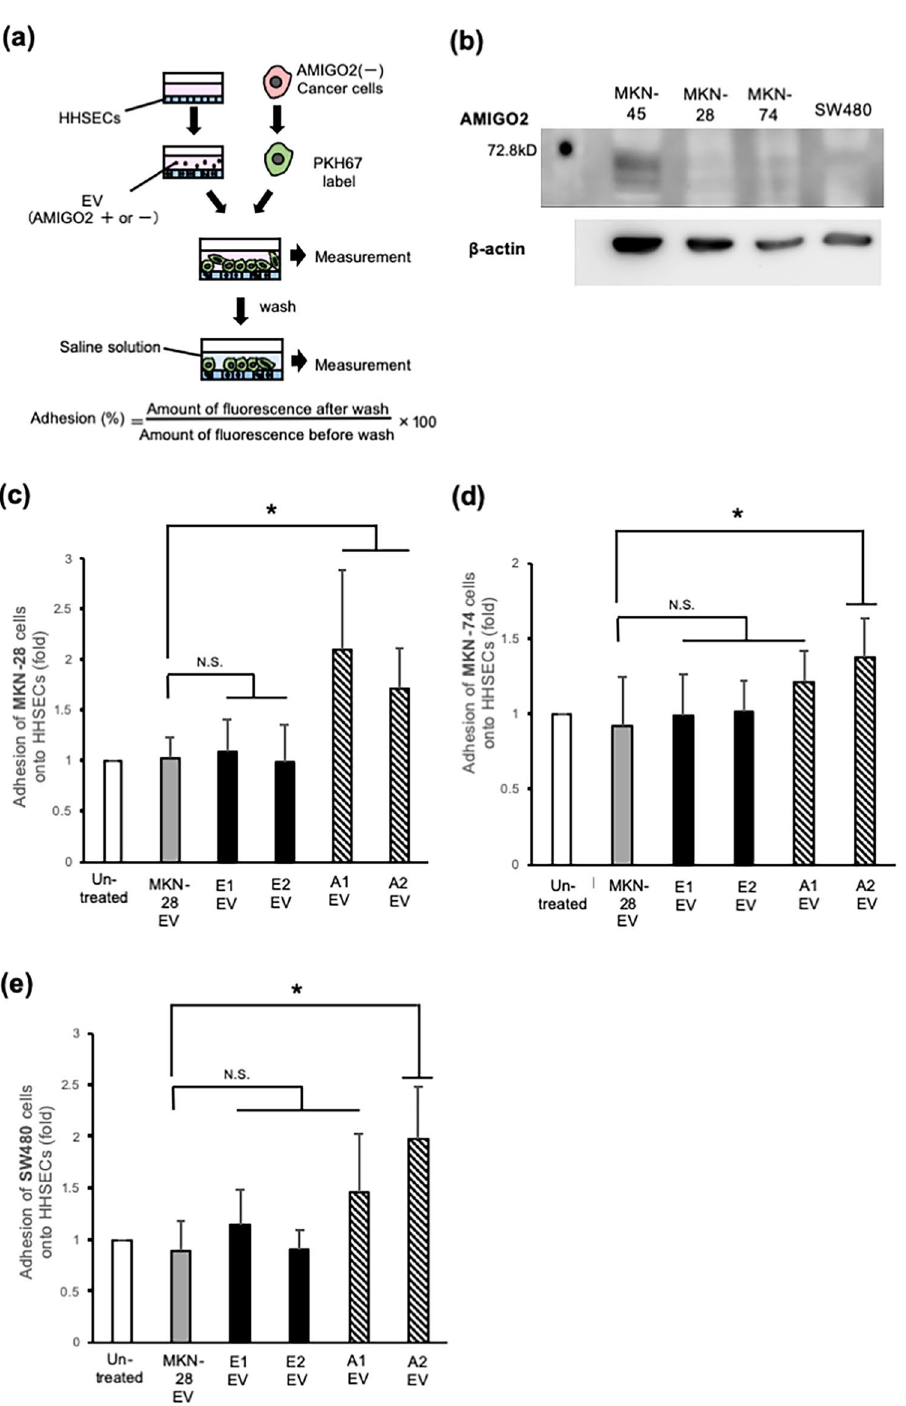
Figure 3. Incorporation of AMIGO2 into HHSECs via EVs mediates adhesion to cancer cells. ( a ) Schematic describing the cancer cell-HHSEC adhesion assay. ( b ) MKN-28, MKN-74, and SW480 cells did not express AMIGO2 by western blotting. Full-length blots were presented in Supplementary Fig. S6. ( c ) The relative adhesion of MKN-28 cells to HHSECs in adhesion assay. Bar graphs show mean ± SD (n = 12 in each group). * P < 0.05 (Dunnett’s test). ( d ) The relative adhesion of MKN-74 cells to HHSECs in adhesion assay. Bar graphs show mean ± SD (n = 19 in each group). * P < 0.05 (Dunnett’s test). ( e ) The relative adhesion of SW480 cells to HHSECs in adhesion assay. Bar graphs show mean ± SD (n = 11 in each group). * P < 0.05 (Dunnett’s test). N.S., no significance based on the Dunnett’s test. These experiments were performed at least 3